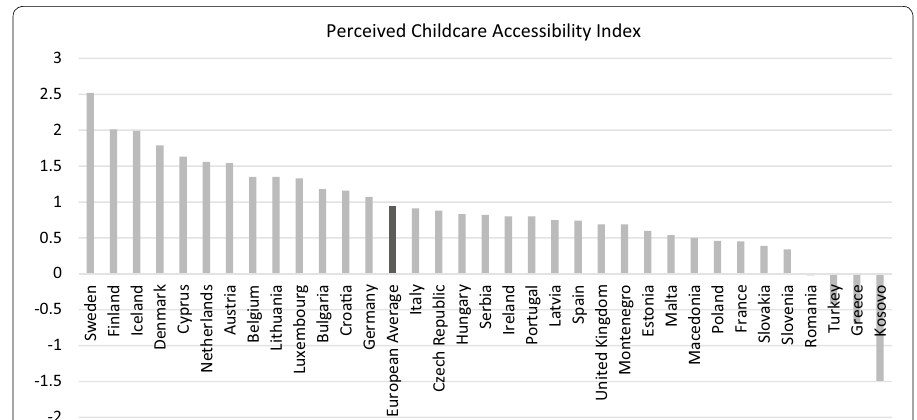
-2.0000-1.5000-1.0000-0.50000.00000.50001.00001.50002.00002.50003.0000 Fig. 2 Perceived childcare accessibility index (PCAI) for households with an income lower and higher than average (self-proclaimed) across Europe (Source: EQLS (2012), weighted